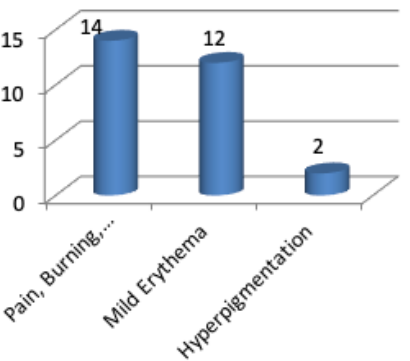
Table 2: Side-effects of lasers procedure in the studied